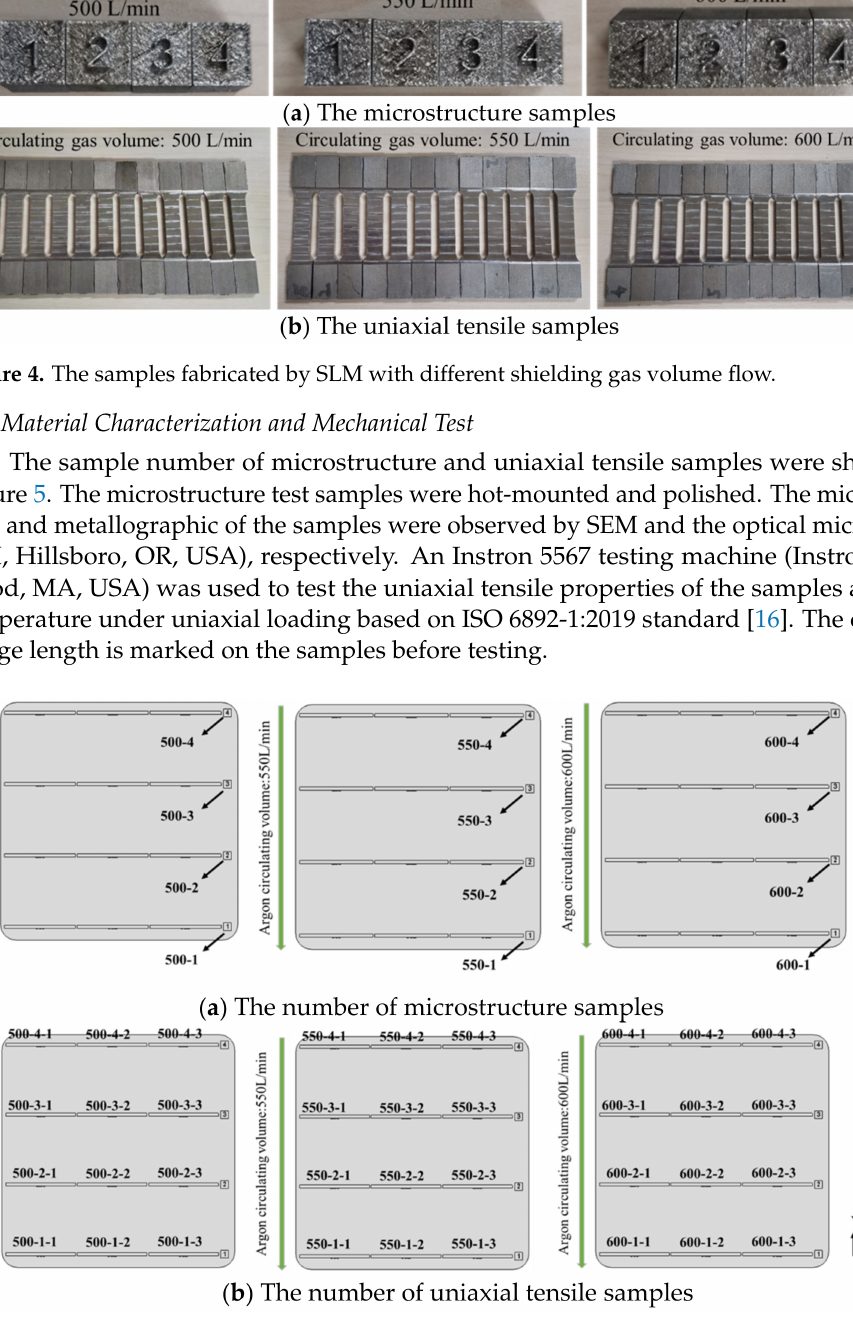
Figure 5. The number of the